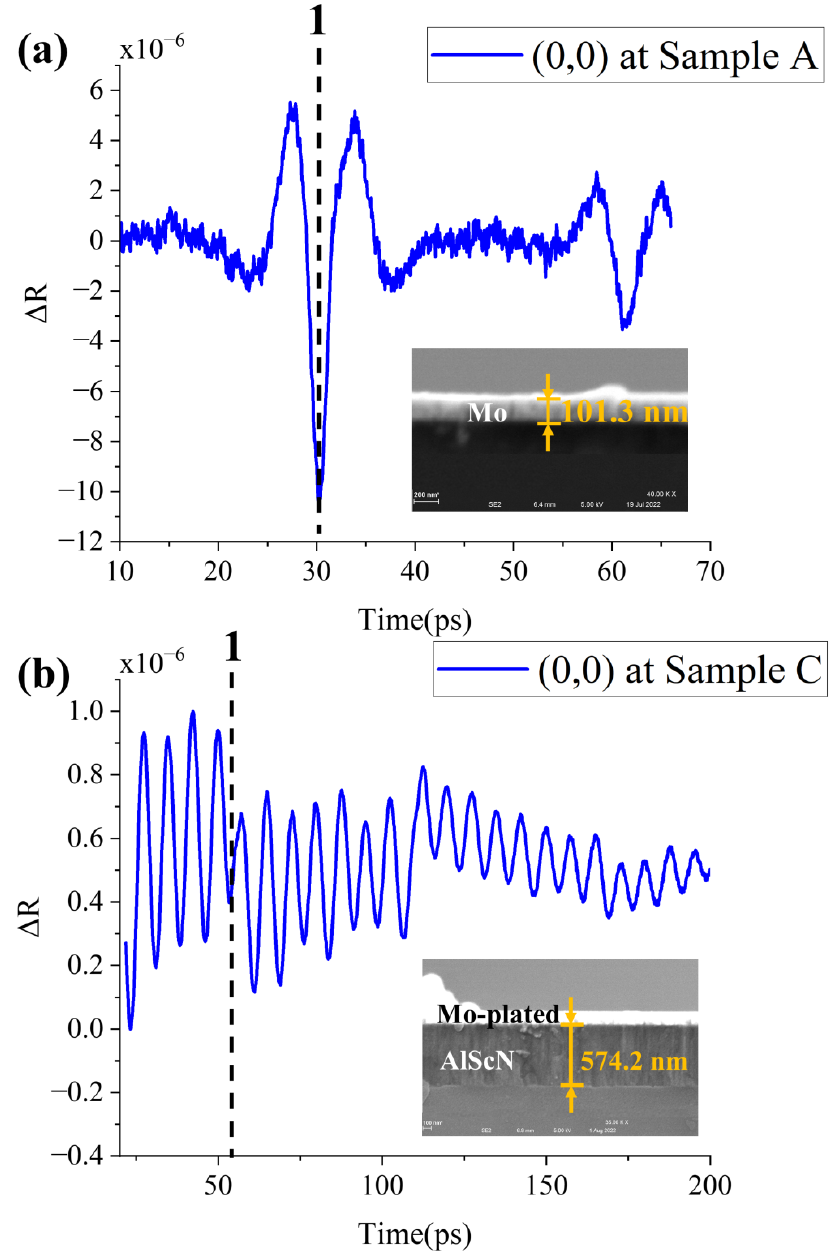
Figure 4. ( a ) Waveform diagram and SEM picture of sample A at (0,0) point. ( b ) Waveform diagram and SEM picture of sample C at (0,0) point. After picosecond ultrasound testing, the sample C is Mo-plated in order to reduce the influence of electron charging during SEM